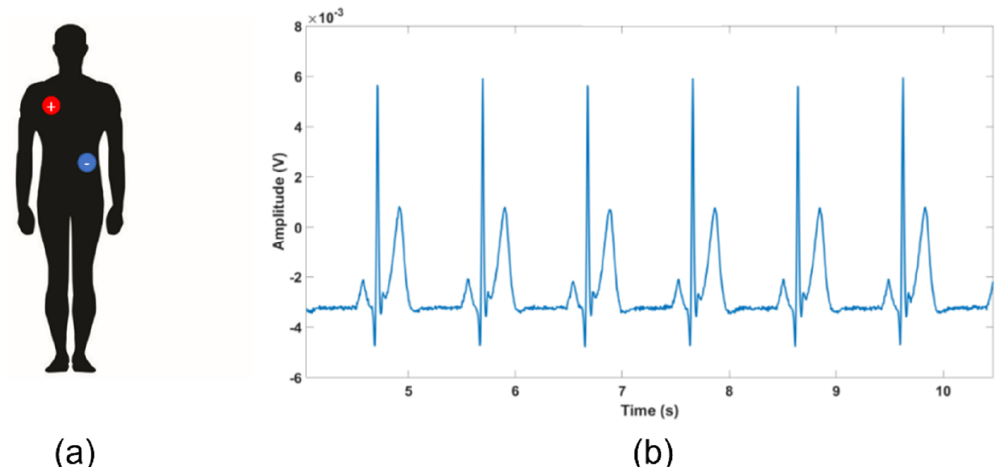
Figure 11. ( a ) Electrodes positioning; ( b ) typical ECG raw trace.